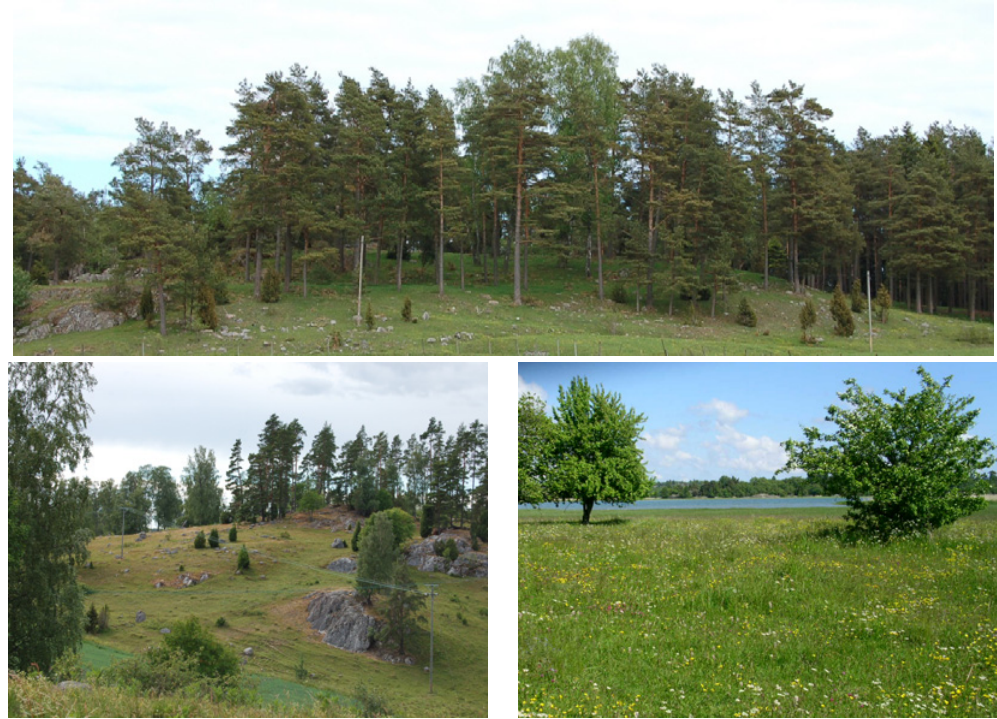
crop-fields. Note that Swedish grasslands have a fairly high abundance of trees and shrubs. long time. The lower right photograph shows a shore meadow that is a result of grassland management but also land uplift, since 200 years ago none of the land in the picture would have been above sea level. However, as this shore meadow has been managed for many centuries there have been plenty of opportunities for plant colonization. Photos by Sara